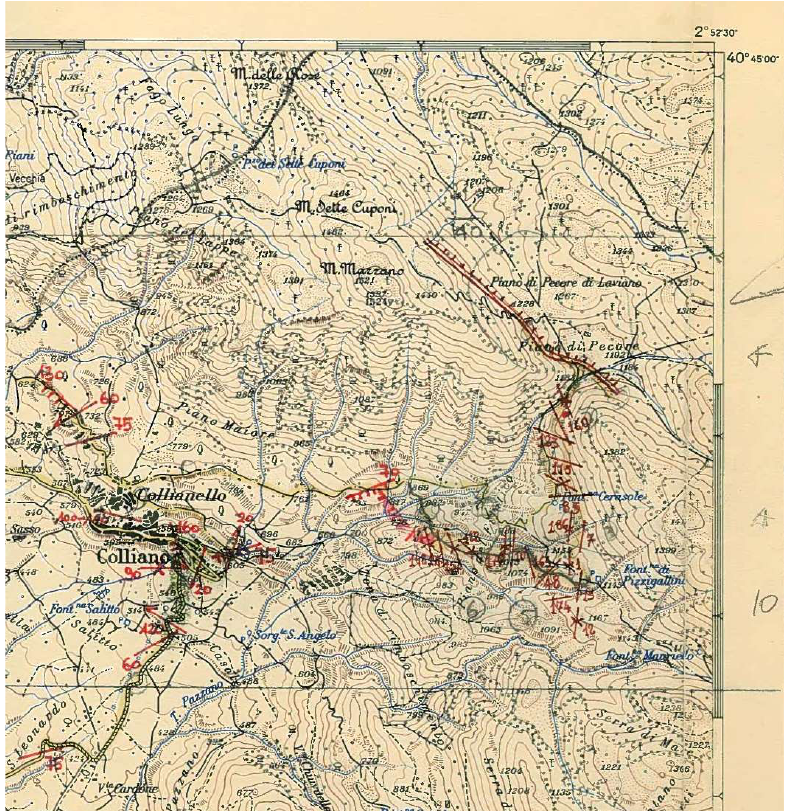
Figure 6. Detail of the original 1:25,000 scale topographical map with the most important geological effects surveyed by Italian geologists immediately after the earthquake of 23.11.1980 (fractures, landslides, faults by Carmignani et al., 1981 [11], see also Supplementary Materials S1) right top corner, trace of the most relevant primary earthquake ruptures located at Piano di Pecore on Monte Marzano (see also Figure 2c; courtesy of Paolo Scandone, PFG).